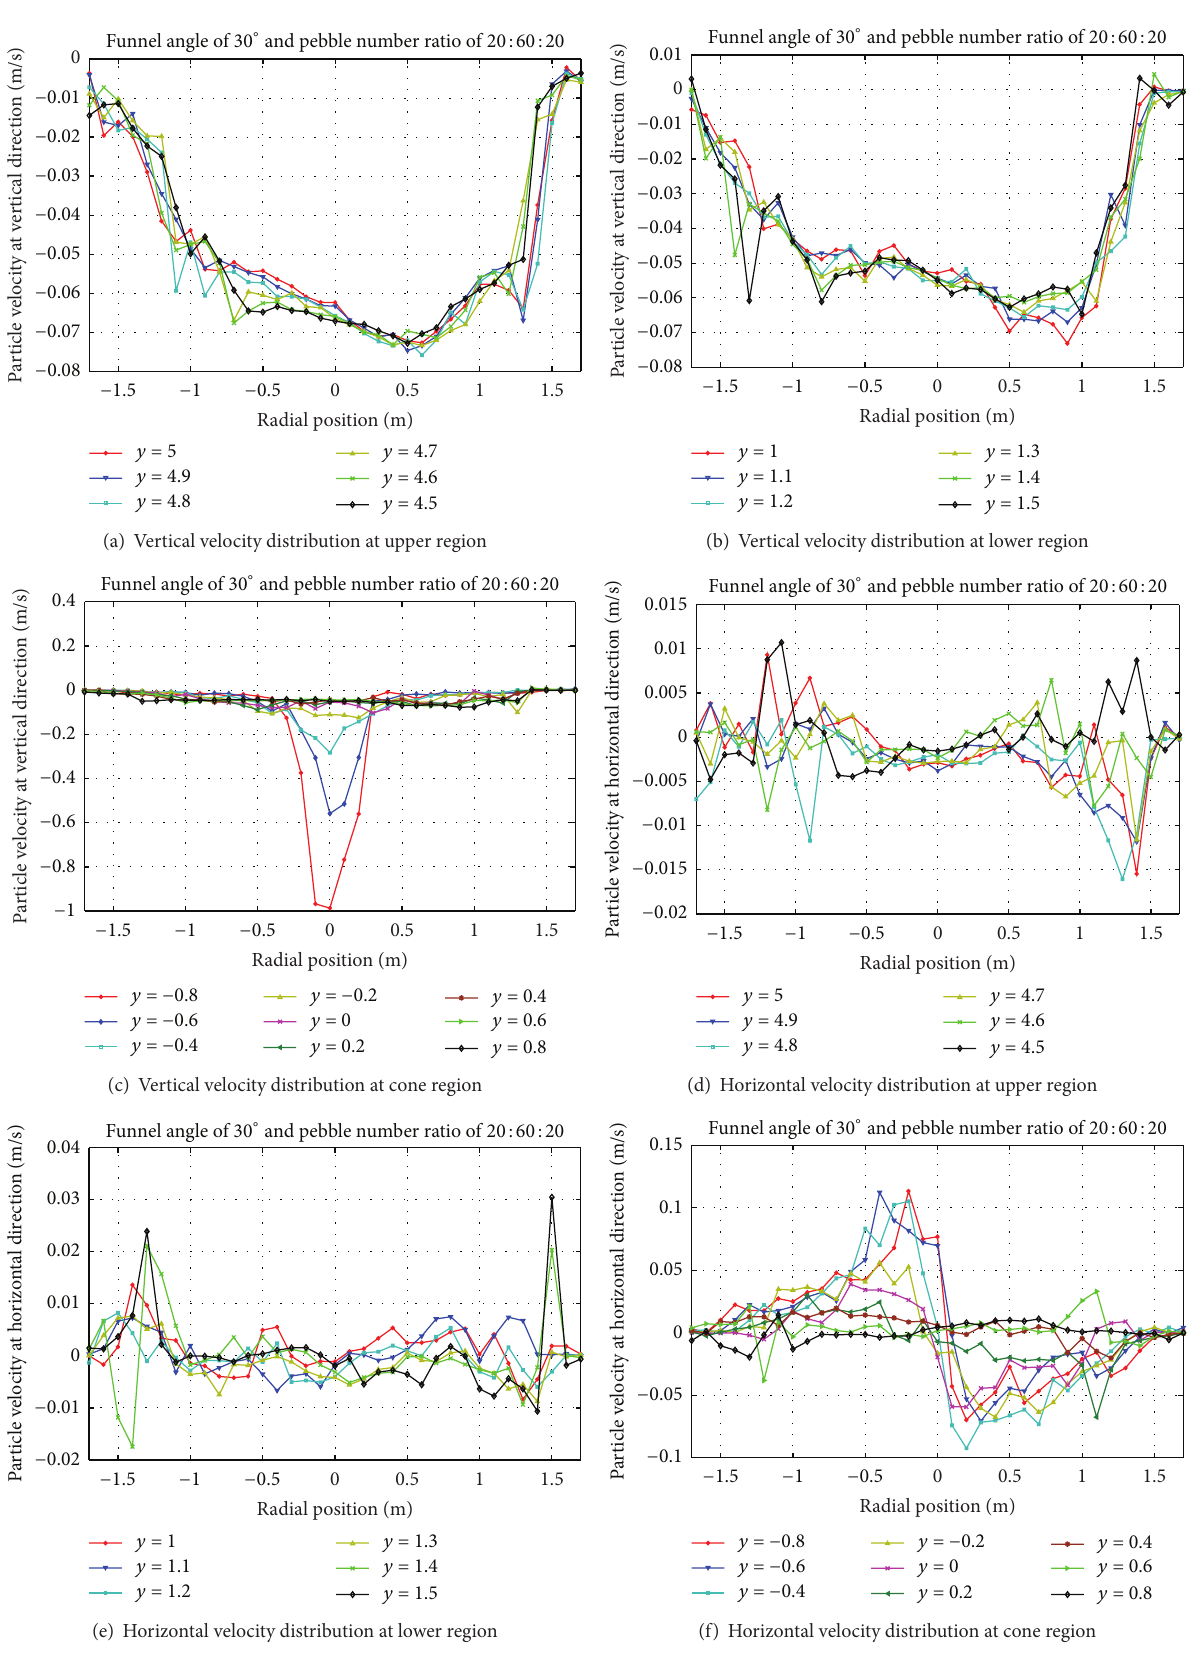
Figure 4: Velocity distributions of pebbles at different positions of the bed with funnel angle of 30 ∘ and particle number ratio 𝑁 𝑓 : 𝑁 𝑔 = 2 :